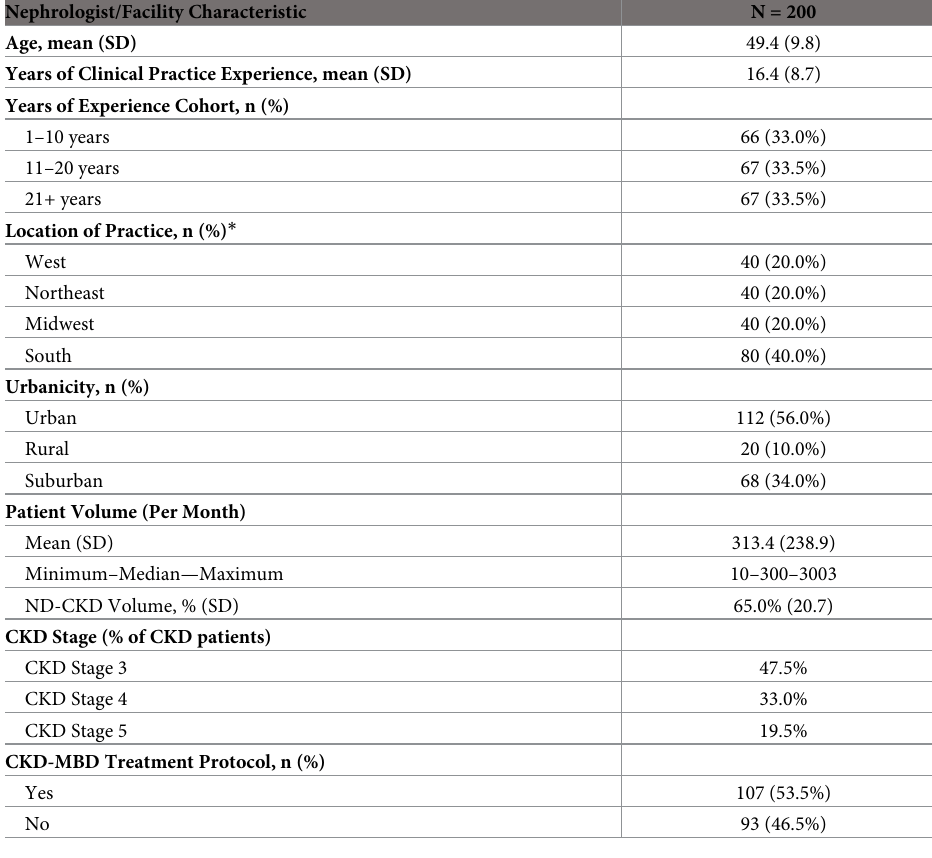
Table 2. Nephrologists’ demographics and facility